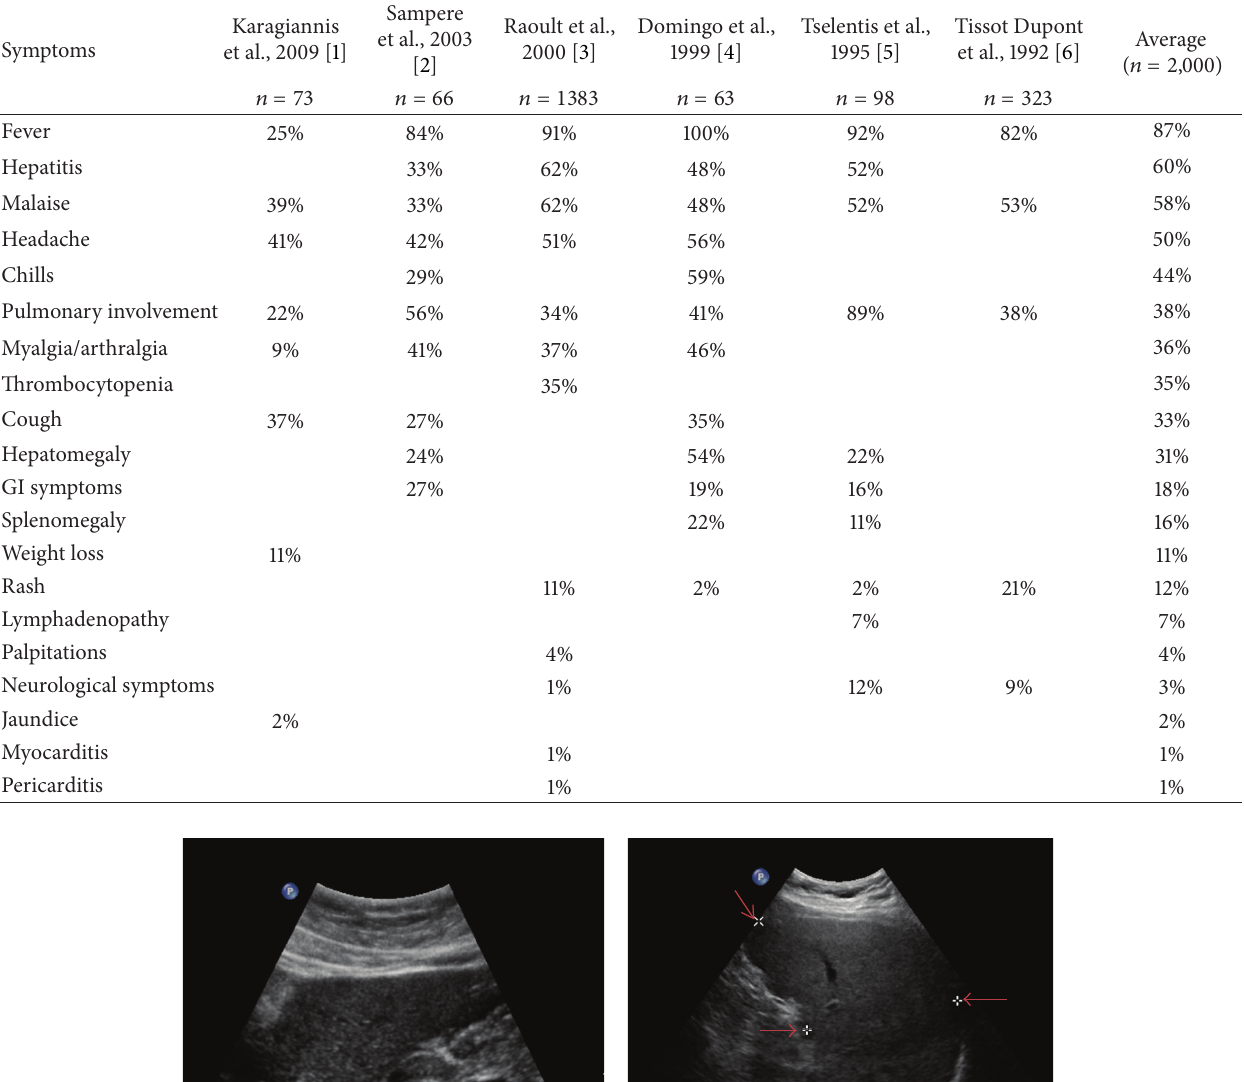
Table 1: Clinical manifestations of Q fever [1–6].